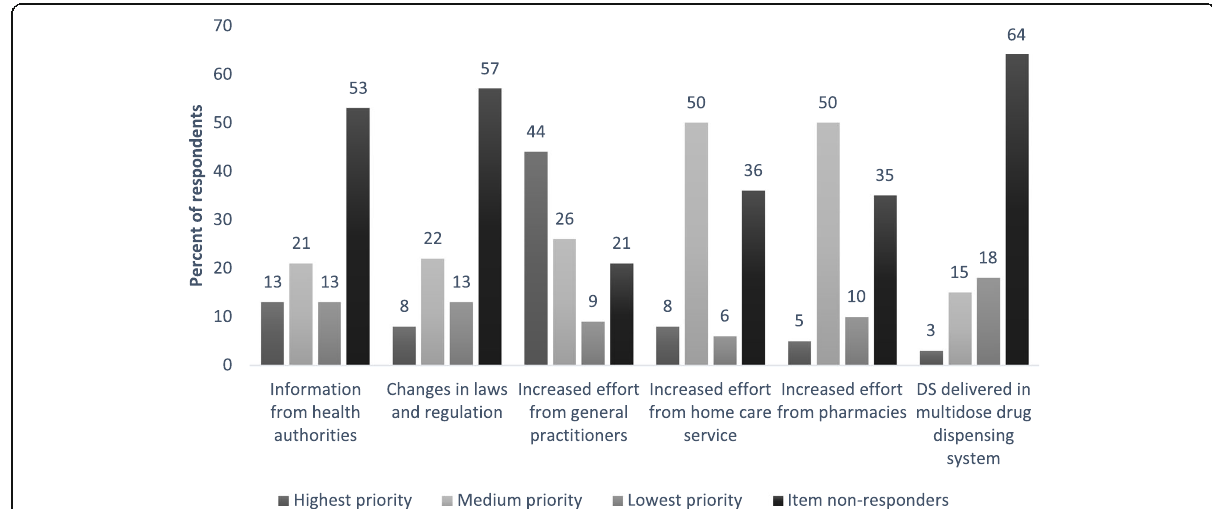
Fig. 3 Pharmacy employees ’ opinions on how to improve the safety of persons with dementia who use dietary supplements. DS, dietary supplements. The employees were given six alternatives on how to ensure the correct and safe use of DS. Respondents were asked to rank the six categories resulting in a ranking scale from 1 to 6. We merged priorities 2 – 4 into a medium-level priority category and priorities 5 – 6 into a lowest-priority